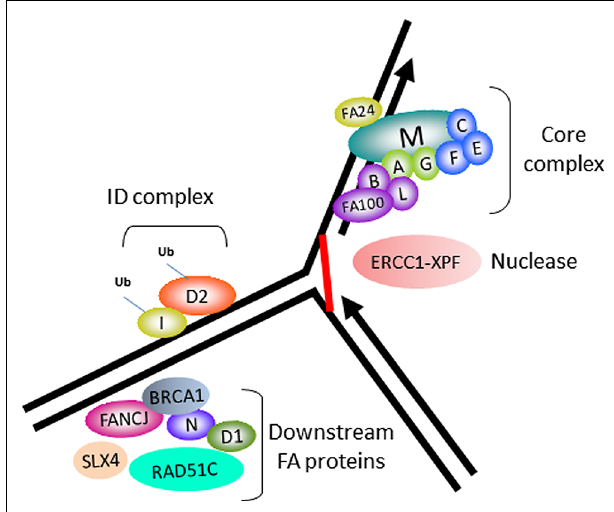
FIGURE 1 | Fanconi anemia (FA) proteins implicated in interstrand cross-link (ICL) repair. Cartoon schematic of the FA proteins implicated in the ICL repair pathway.The integrity of the core complex is required for FANCD2/FANCI monoubiquitination, a key activation step of the FA pathway. ERCC1-XPF is the nuclease implicated in ICL processing. FANCJ and certain other FA proteins are not required for FANCD2/FANCI monoubiquitination, and are therefore implicated in downstream events of the FA pathway, such as homologous recombination (HR) repair of the processed